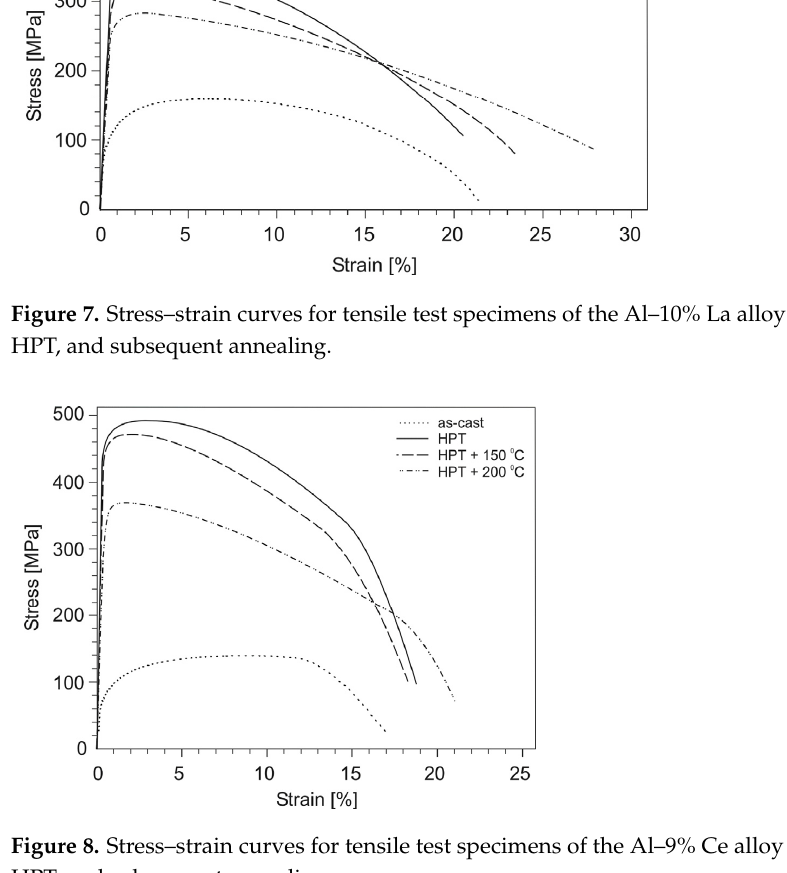
Figure 9. Stress–strain curves for tensile test specimens of the Al–7% Ni alloy in as-cast state, after HPT, and subsequent annealing.